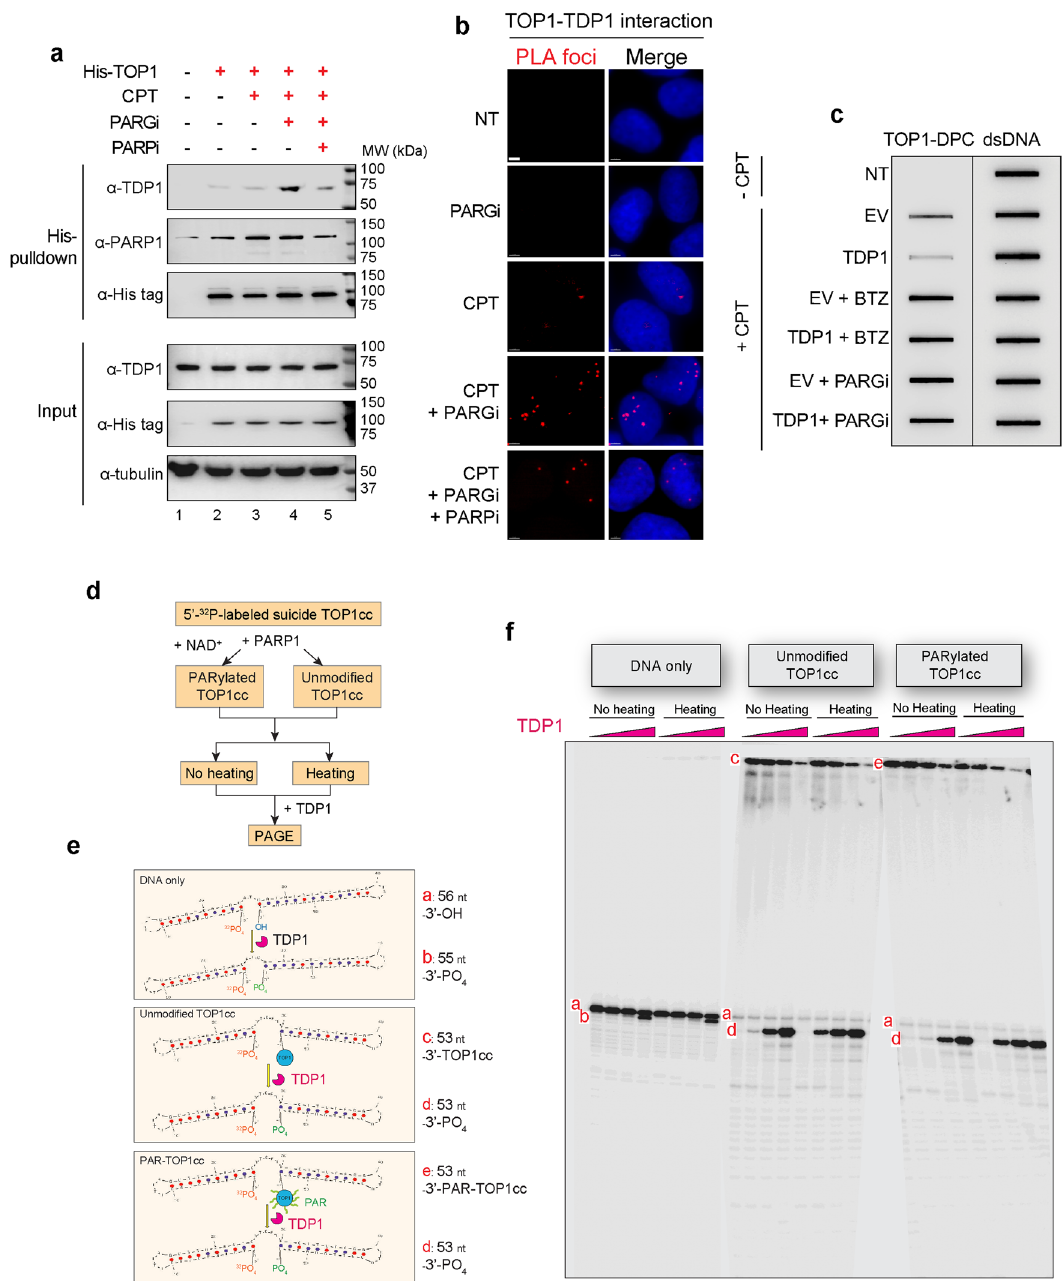
Fig. 3 TOP1-PARylation enhances TDP1 recruitment without enhancing TOP1cc hydrolysis. a TOP1-TDP1 interaction was enhanced by PARGi and inhibited by PARPi. Following transfection of 6×His-tagged TOP1 expression construct, HEK293 cells were treated with the indicated drugs before His-tag pulldown using Ni-NTA agarose under native conditions. The pulldown and input samples were Western blotted with the indicated antibodies. b Proximity Ligase Assay (PLA) con fi rming that inhibiting PARG enhanced TOP1-TDP1 interactions. U2OS cells were treated with CPT (20 µ M, 1 h), PARGi (10 µ M, 2 h), or CPT + PARGi (pre-treatment with PARGi for 1 h then co-treatment with CPT and PARGi for 1 h), followed by PLA assay. The scale bar represents 3 μ m. c ICE assay showing that TDP1 failed to resolve hyper-PARylated TOP1-DPCs in vivo. HEK293 cells transfected with empty vector (EV) or TDP1- FLAG overexpression plasmid were treated with CPT (2 µ M) for 1 h in the absence or presence of PARGi or BTZ. Cells were collected for ICE assay. 2 µ g of digested DNA from each ICE assay sample was subjected for slot-blotting using α -TOP1 antibody or α -dsDNA antibody. d Scheme for [ 32 P]-labeled TOP1cc preparation, PARylation, and TDP1 digestion assays. e Schematic representation of the reaction products generated by TDP1 with the DNA suicidal substrate alone, unmodi fi ed TOP1ccs, and PARylated TOP1ccs. f TDP1 acted on unmodi fi ed and PARylated TOP1-DPCs at high concentrations in vitro. Representative TDP1 assay as described in panel ( d ) showing the 3 ′ -nucleosidase activity of TDP1 (left set of eight samples) and TDP1 ’ s phosphodiesterase activity toward unmodi fi ed TOP1-DPC (middle 8 samples), which is facilitated by heat denaturation of TOP1cc but does not exhibit signi fi cantly altered activity toward PARylated-TOP1cc (right eight samples). TDP1 concentrations: 0, 1.25, 25 and 500